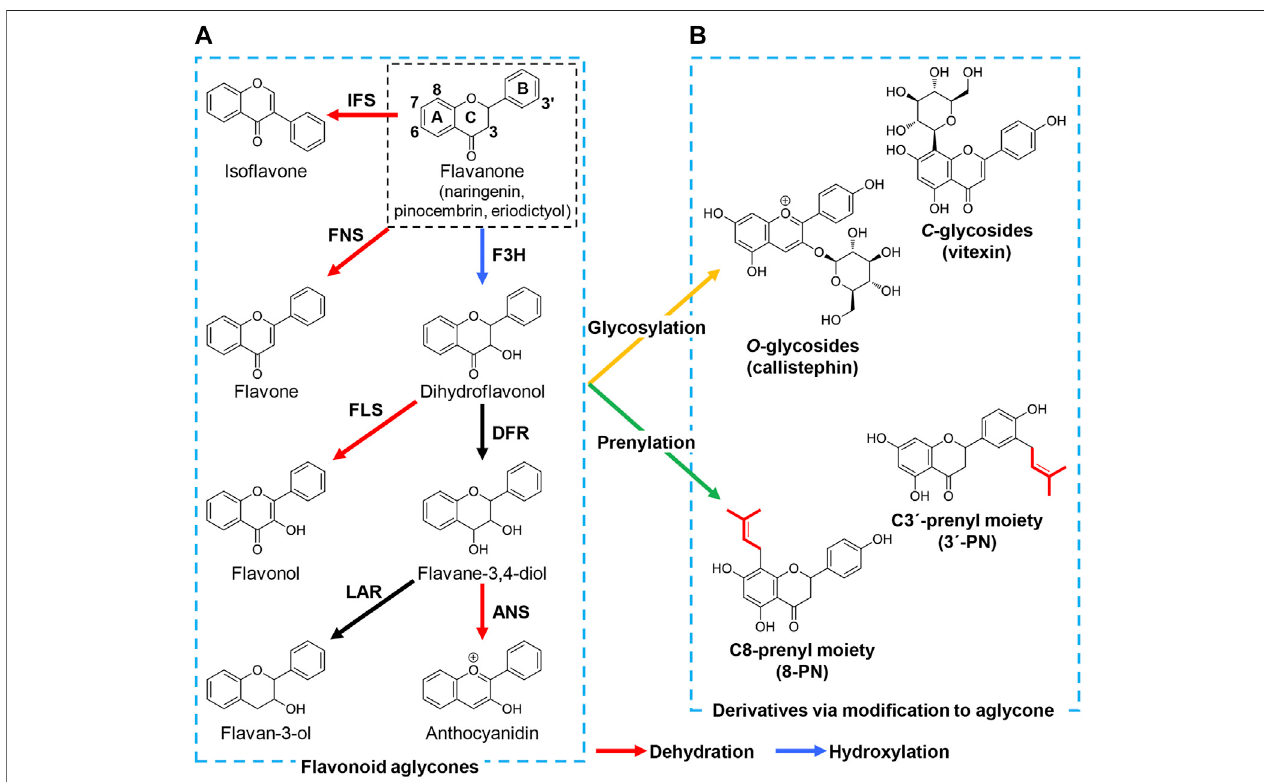
FIGURE 1 | Structure and biosynthesis of major fl avonoid aglycones and their derivatives. The (A) represents the core structures and biosynthetic pathway of fl avonoid aglycones: fl avanone, fl avone, dihydro fl avonol, fl avonol, fl avane-3,4-diol, anthocyanidin, fl avane-3-ol, and iso fl avone. In brief, fl avanone is hydroxylated to dihydro fl avonol by F3H. FLS, and DFR catalyze the dehydration and hydroxylation of dihydro fl avonol, yielding fl avonol, and fl avane-3,4-diol, respectively. Flavane-3,4- diol is converted toanthocyanidin byANS and fl avane-3-ol byLAR. Flavone and iso fl avone arealso synthesized from naringeninby FNS and IFS, respectively. The (B) shows the formation of derivatives via modi fi cation to fl avonoid aglycones. Sugar and prenyl moieties are attached to the hydroxyl group(s) and carbon atom(s) of fl avonoidaglyconestoform fl avonoidglycosidesandprenylated fl avonoids,suchascallistephin(pelargonidin-3- O -glucoside,oneofanthocyanins)andvitexin(apigenin- 8- C -glycoside), 8-prenylnaringenin (8-PN) and 3 ′ -prenylnaringenin (3 ′ -PN). Red, blue, orange, and green arrows indicate enzymatic reactions of dehydration, hydroxylation,glycosylation,andprenylationrespectively.F3H, fl avanone-3-hydroxylase;FLS, fl avonolsynthase;DFR,dihydro fl avonol4-reductase;ANS,anthocyanidin synthase; LAR, leucoanthocyanidin reductase; FNS, fl avone synthase; IFS, iso fl avone synthase.